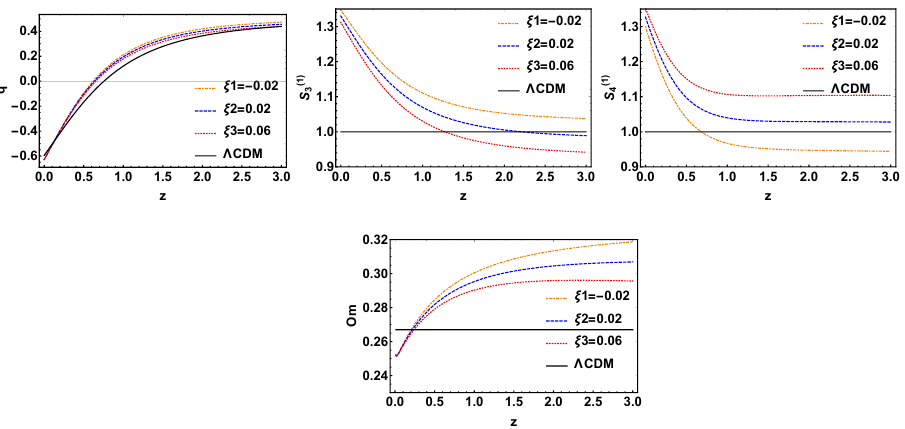
( 1 ) ( 1 ) , S and Om , respectively, versus red shift z for the 3 4